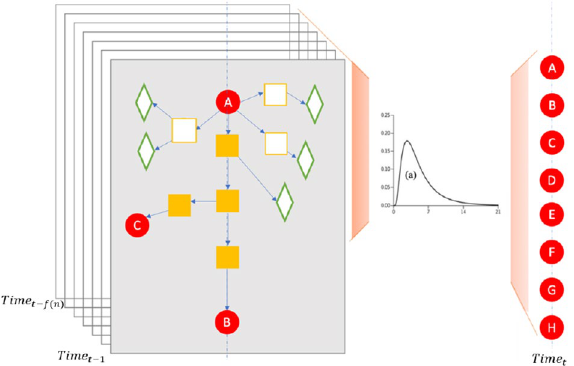
Figure 1. The learning and inference scheme of the CLIIP model. The diagram shows continuous backtracking learning while the newly infected people are being recorded. Given n is the maximum day of incubation